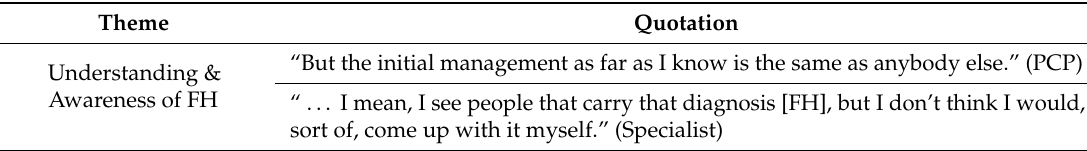
Table 2. Themes and representative quotations identified from physician